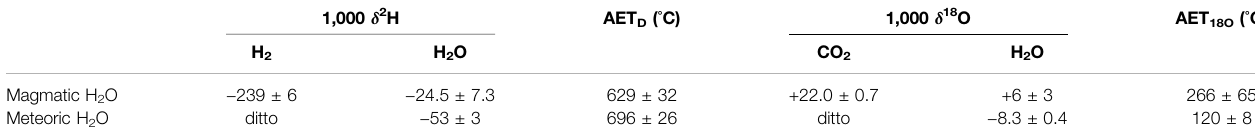
TABLE 2 | Isotopic compositions of fumarolic H 2 and CO 2 estimated from the plume samples, together with apparent equilibrium temperatures calculated assuming hydrogen isotope exchange equilibrium between H 2 and H 2 O (AET D ) and oxygen isotope exchange equilibrium between CO 2 and H 2 O (AET 18O ). In addition to the isotope exchange equilibrium with magmatic H 2 O, that with meteoric H 2 O is presented for comparison.